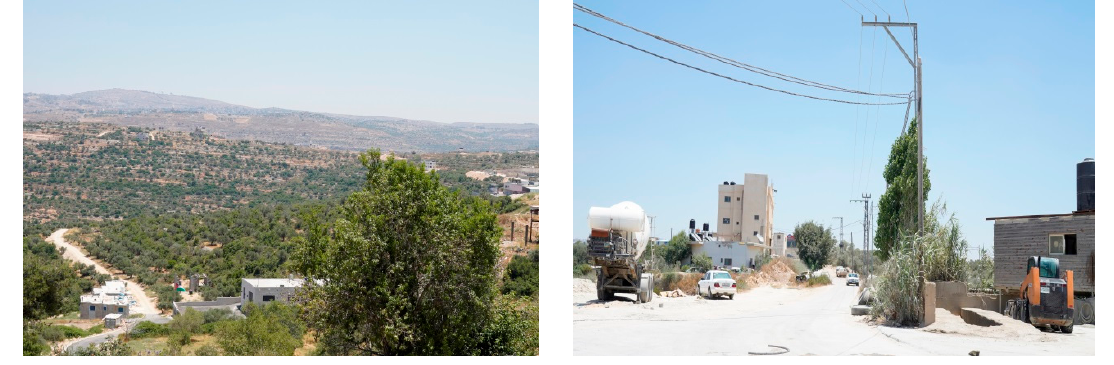
Figure 2. Dust and air pollution from quarry activities as described by the population close to the quarry sites ( n = 79).